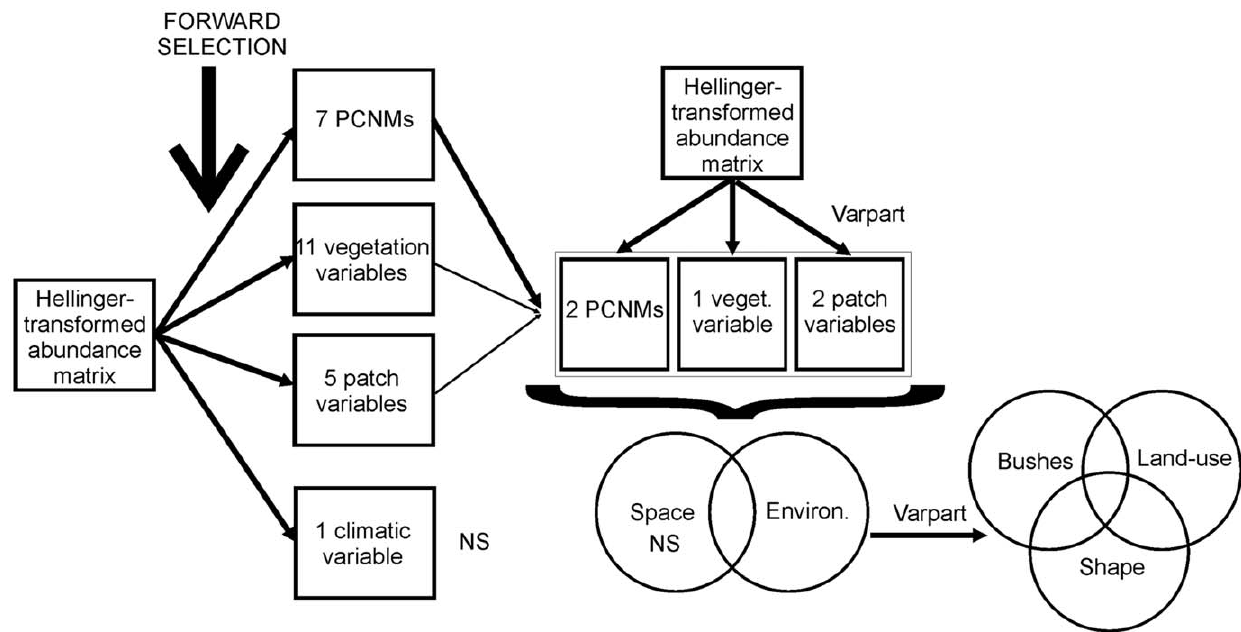
Figure 2. Diagram of the statistical steps. Diagram of the different data sets used and the analytical steps performed with respect to the four predictor data matrices. Varpart = variation partitioning. NS = not significant. PCNM = principal coordinates of neighbor matrices. Analysis initiated by performing a selection of variables from each data matrix. The selected variables were grouped in a unique data matrix, which was subjected to a variation partitioning method to separate the influence of space and environment. Finally, the environmental and spatially structured environmental portion of variation was subjected to the variation partitioning to separate the unique and joint effects of environmental variables on metacommunity structure.